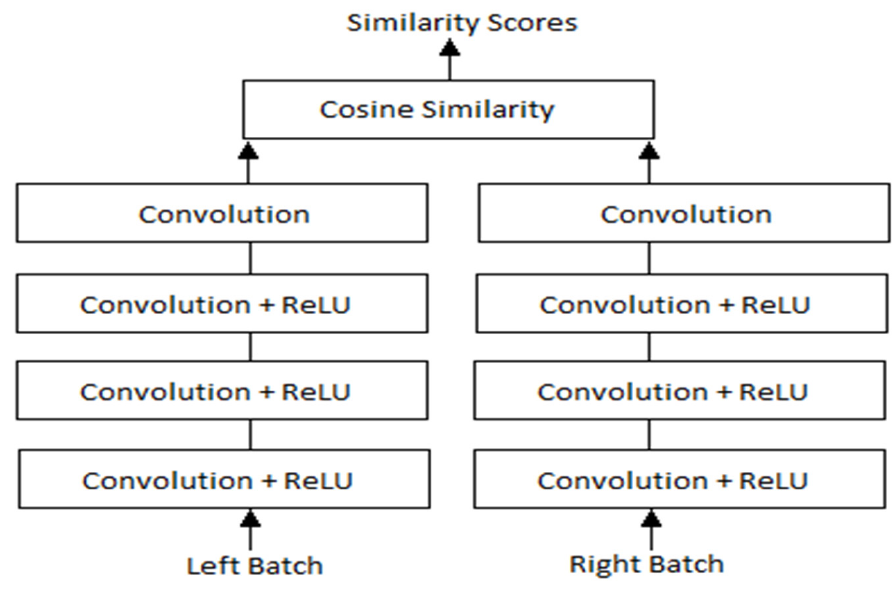
Figure 3. The architecture of the network